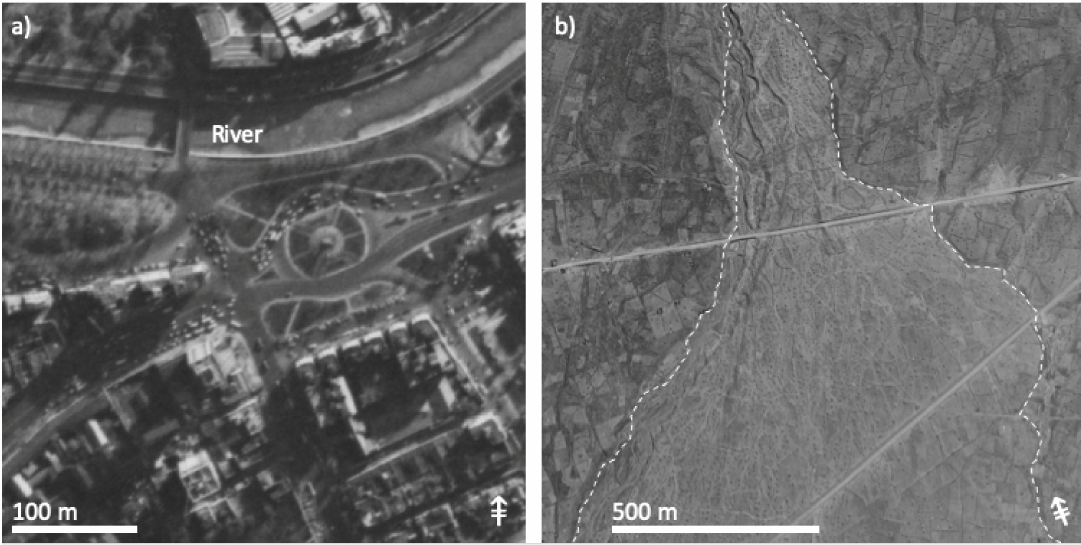
Figure 10. Details of ( a ) Santiago de Chile, north of the city centre, Plaza Baquedano on ( a ) KH9-3 image from 1972 and ( b ) riverbed in El Alto, directly west of the airport on KH-7 image from 1967 (Data: Table